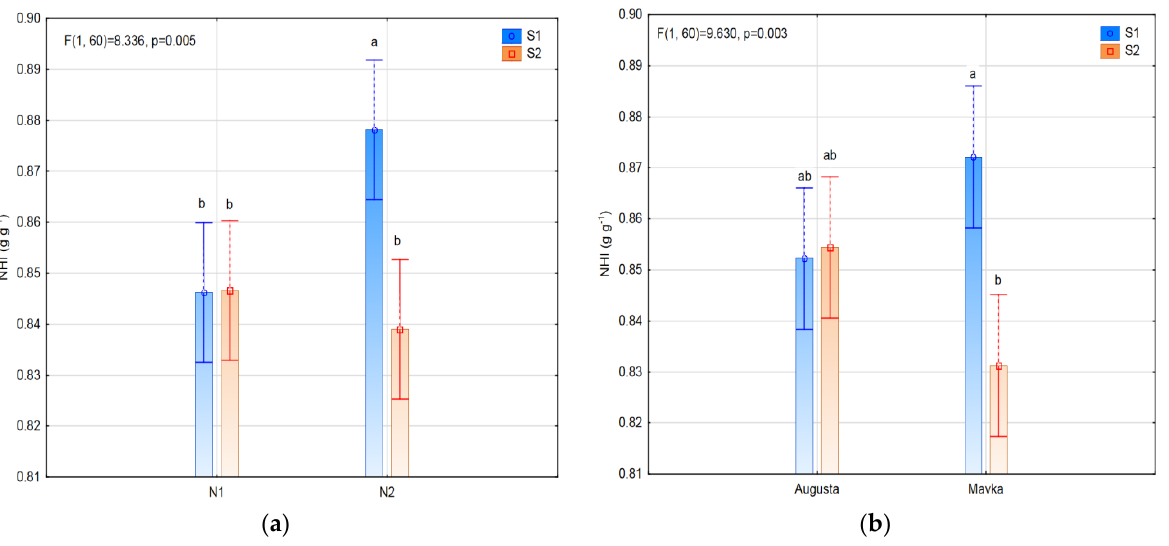
Figure 7. Significant effect of interaction of fertilizer and sowing date ( a ) and cultivar and sowing date on NHI ( b ). The standard error (SD) of each mean is presented as an error bar. The occurrence of the same letter pointer at averages (at least one) means that there is no statistically significant difference between them.